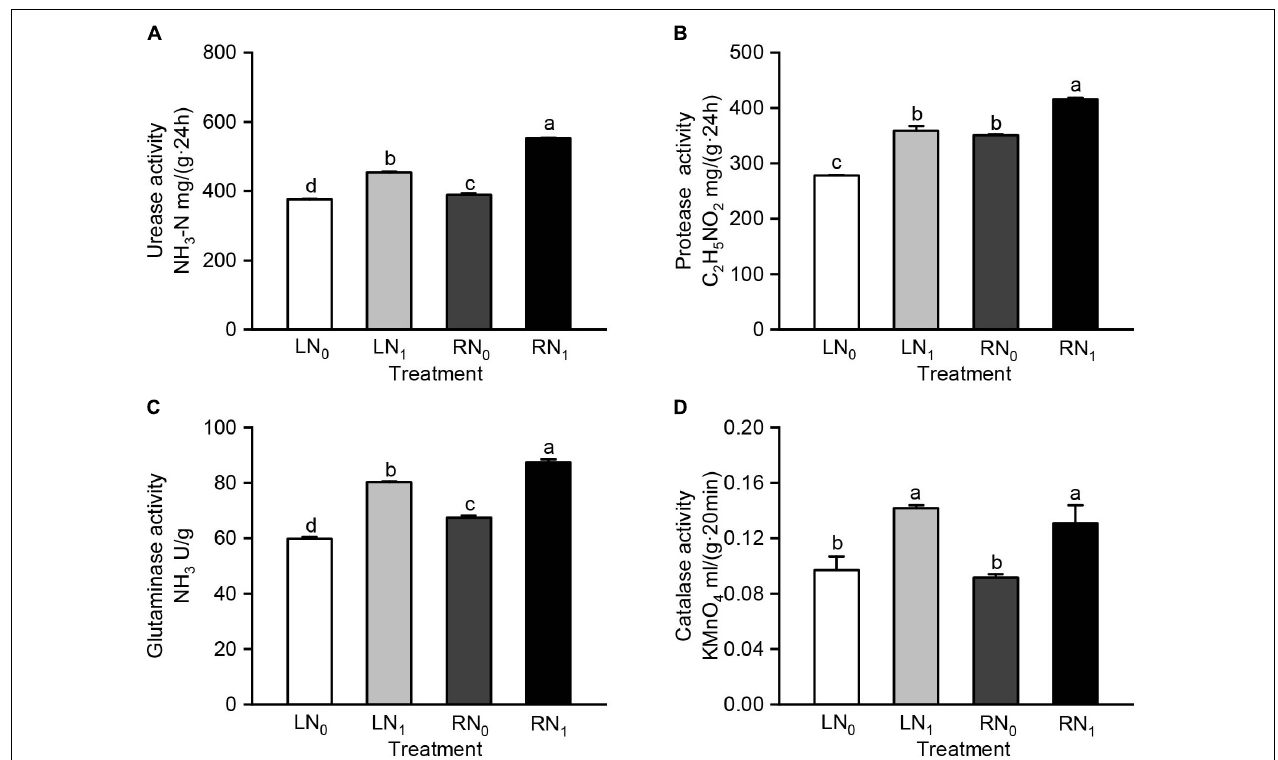
FIGURE 3 | Comparisons of (A) soil urease activity, (B) soil protease activity, (C) soil glutaminase activity, and (D) soil catalase activity among different treatments. L and R were low and room temperature treatments, N 0 and N 1 were non-nitrogen and nitrogen treatments. Values were shown as means ± standard deviations (SD, n = 3). Different lowercase letters were indicated statistically significant differences between the four treatments at 0.05